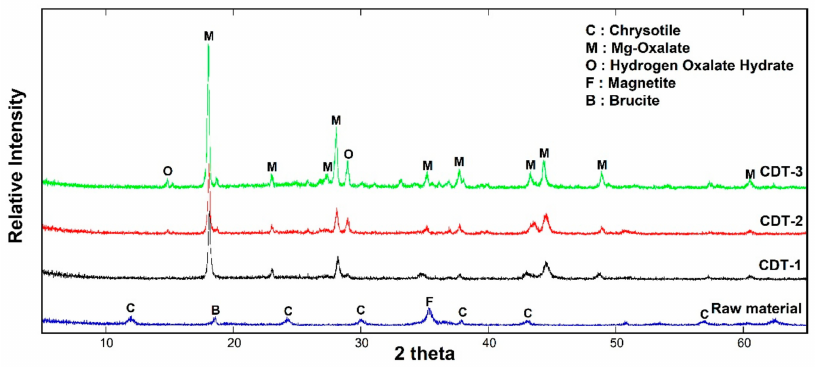
Figure 2. XRD results of raw material and solid samples obtained from low temperature detoxification test using chrysotile (CDT-1, 2, and 3).